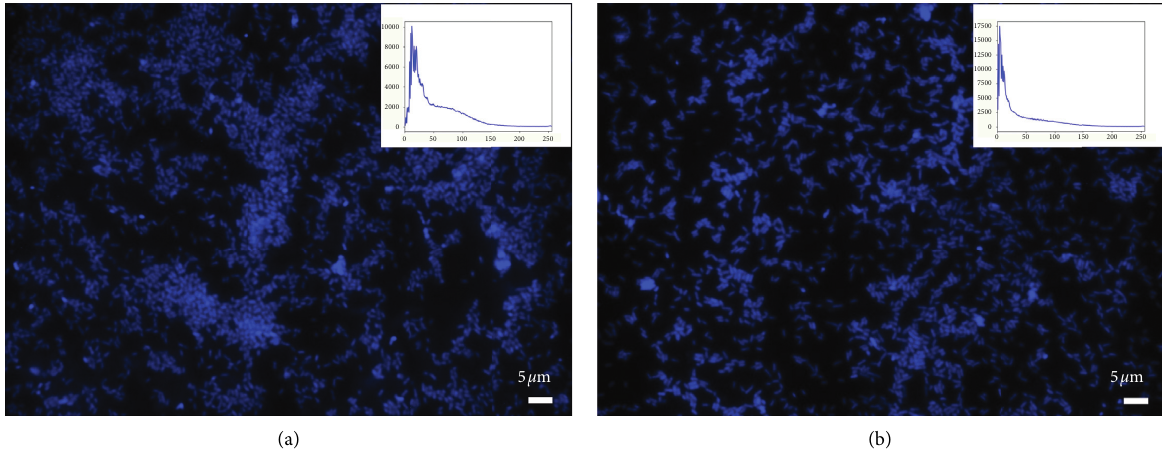
Figure 3: Effect of AgNPs in S. braenderup DNA integrity assessed by fluorescence microscopy with DAPI staining. In the presence of AgNPs, a concentration ratio of 1 :1 for 1 hr (a) and concentration ratio of 1:1 for 2hrs (b).